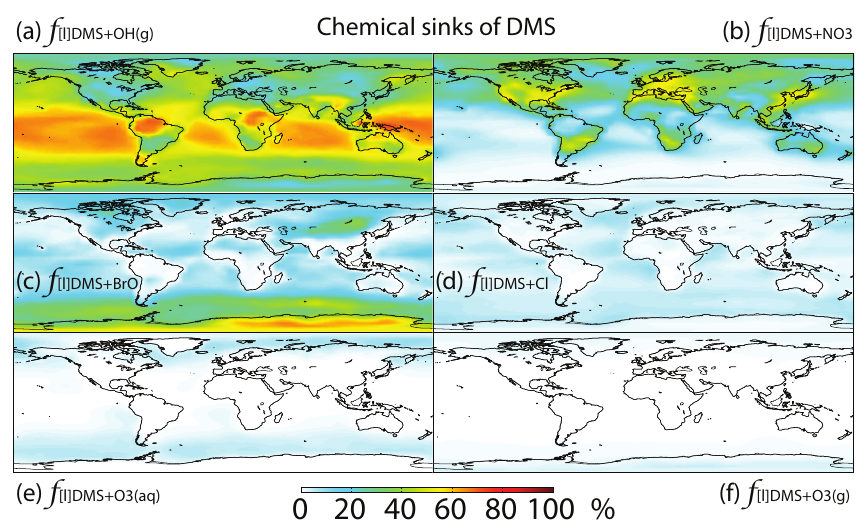
Figure 3. Global tropospheric distribution of annual-mean percentage of DMS oxidized in the troposphere via (a) DMS + OH ( g ) ( f [ l ] DMS + OH ( g ) ), (b) DMS + NO 3 ( f [ l ] DMS + NO ), (c) DMS + BrO ( f [ l ] DMS + BrO ), (d) DMS + Cl ( f [ l ] DMS + Cl ), (e) DMS + O 3 ( aq ) 3 ( f [ l ] DMS + O ) and (f) DMS + O 3 ( g ) ( f [ l ] DMS + O 3 ( aq ) 3 ( g )